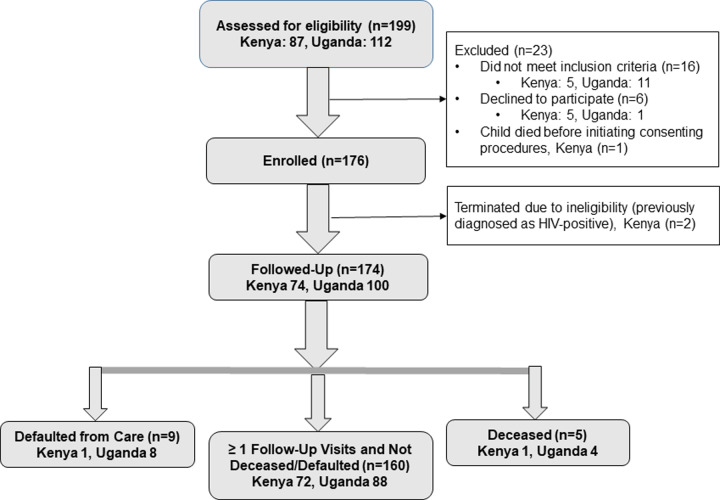
Screening, enrollment and follow-up.